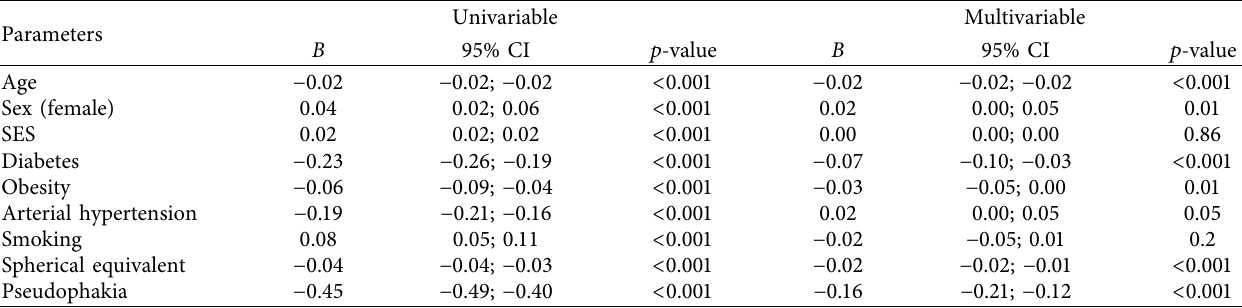
Table 1: Association analysis of systemic parameters and pupil size. Data from the population-based Gutenberg Health Study in 2012–17 ( n � 18, 176